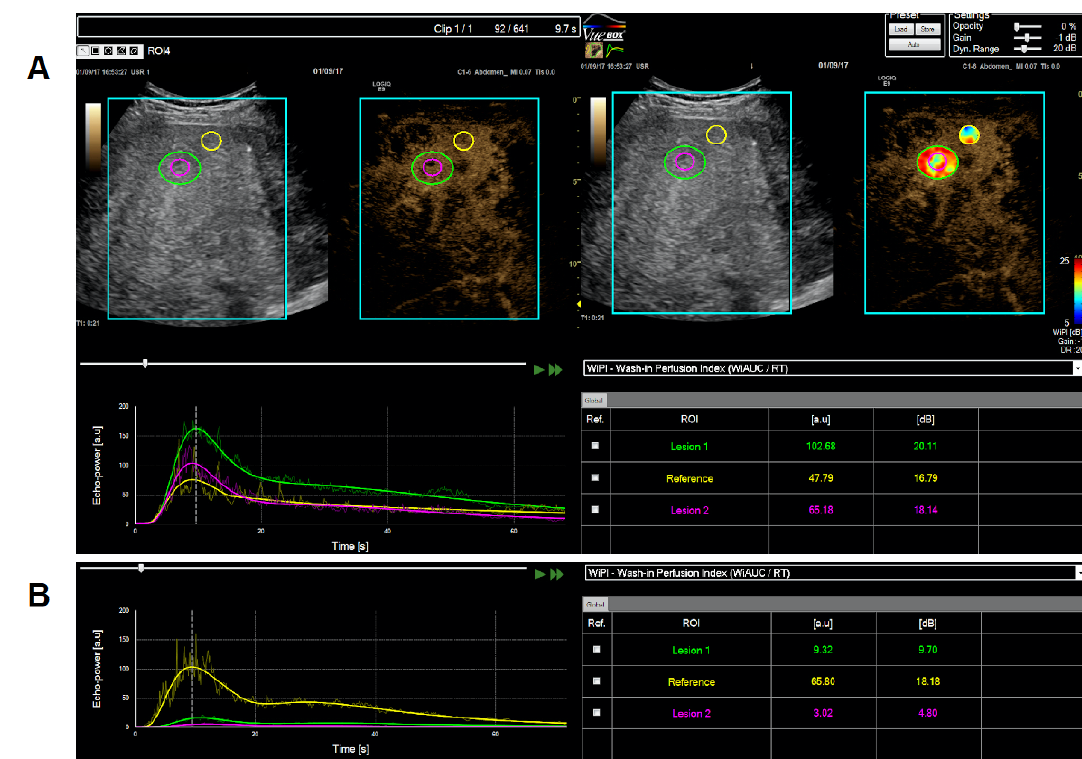
Figure 2. Contrast-enhanced ultrasound (CEUS) measurement (UPN 006) of wash-in perfusion index (WIAUC/RT, see Supplementary Figure 1) in liver metastasis (green and purple) versus normal liver (yellow) reference region of interest (ROI) before (upper panel, A ) versus after 5 days of treatment with 2.5 mg/m 2 tTF-NGR per day (lower panel, B ).